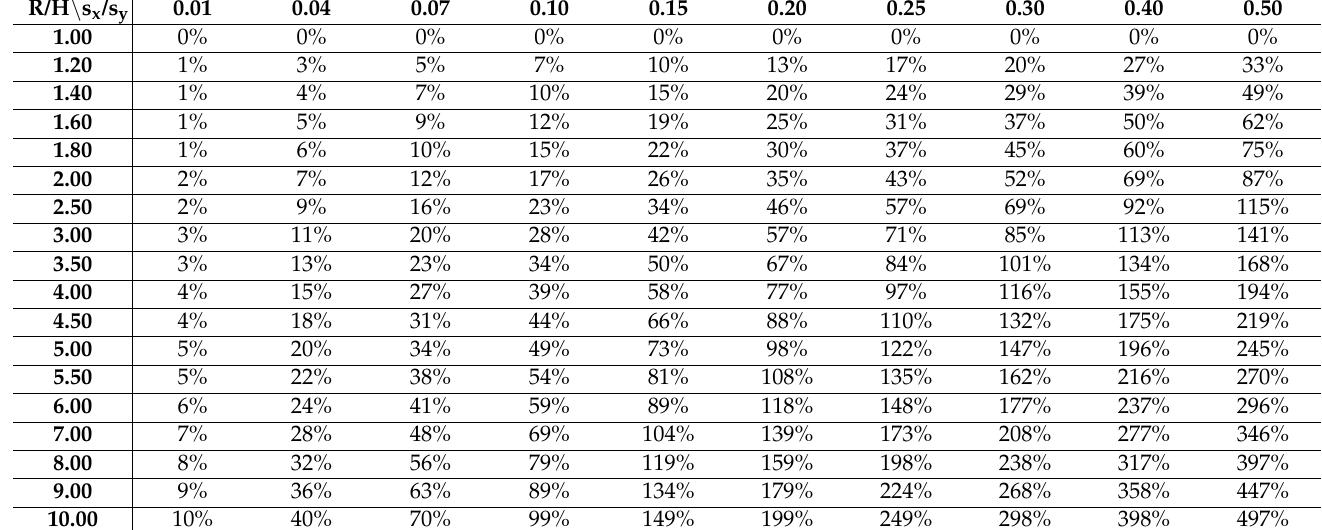
Table 1. Values of the Interpretation Error E I for R / H and s x / s y ratios commonly used in